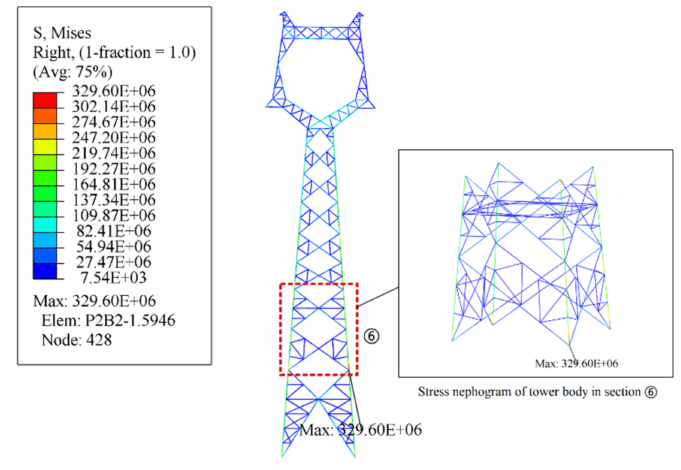
Figure 7. Stress nephogram of the transmission tower (V10 = 26 m/s).